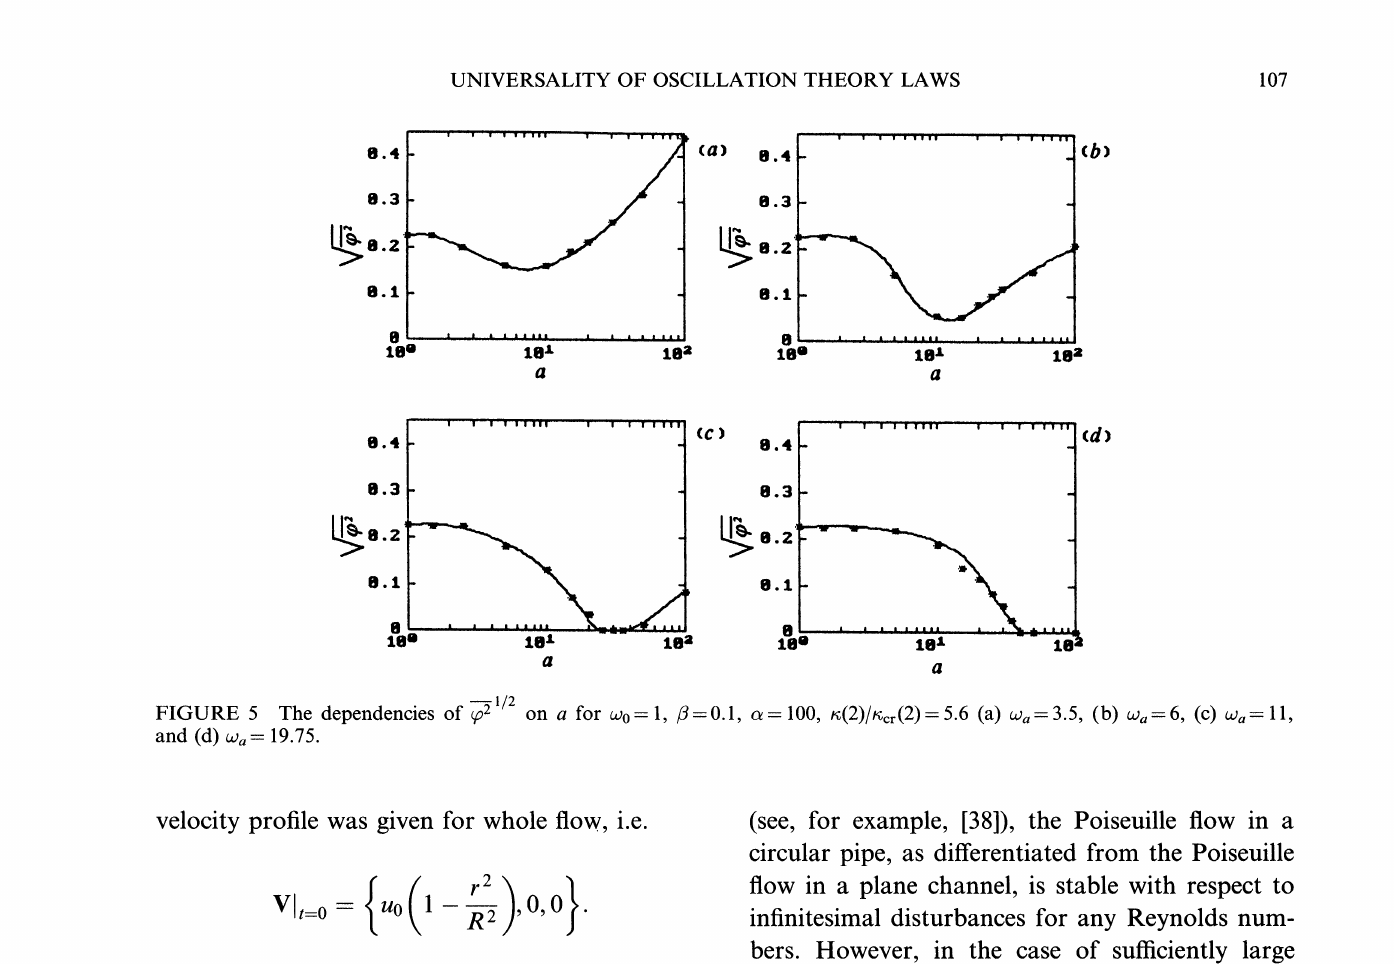
velocity profile was given for whole flow.,